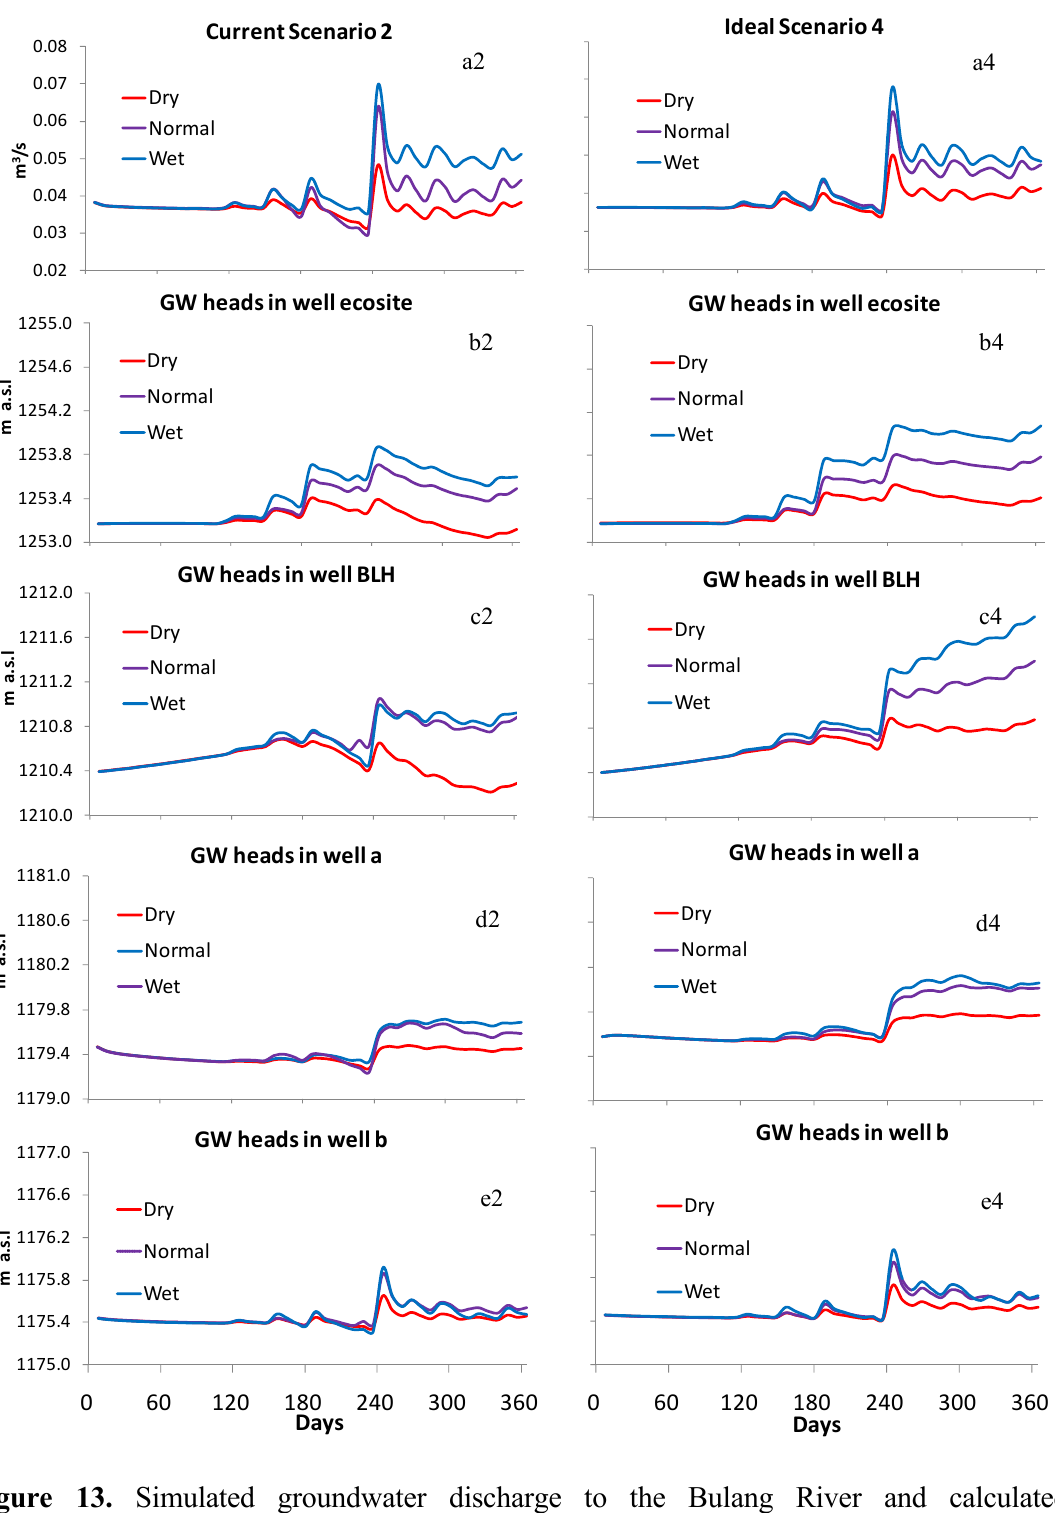
Figure 13. Simulated groundwater discharge to the Bulang River and calculated groundwater heads with current land use ( a2 – e2 ); and Ideal land use scenario ( a4 – e4 ) under dry, normal and wet hydrological